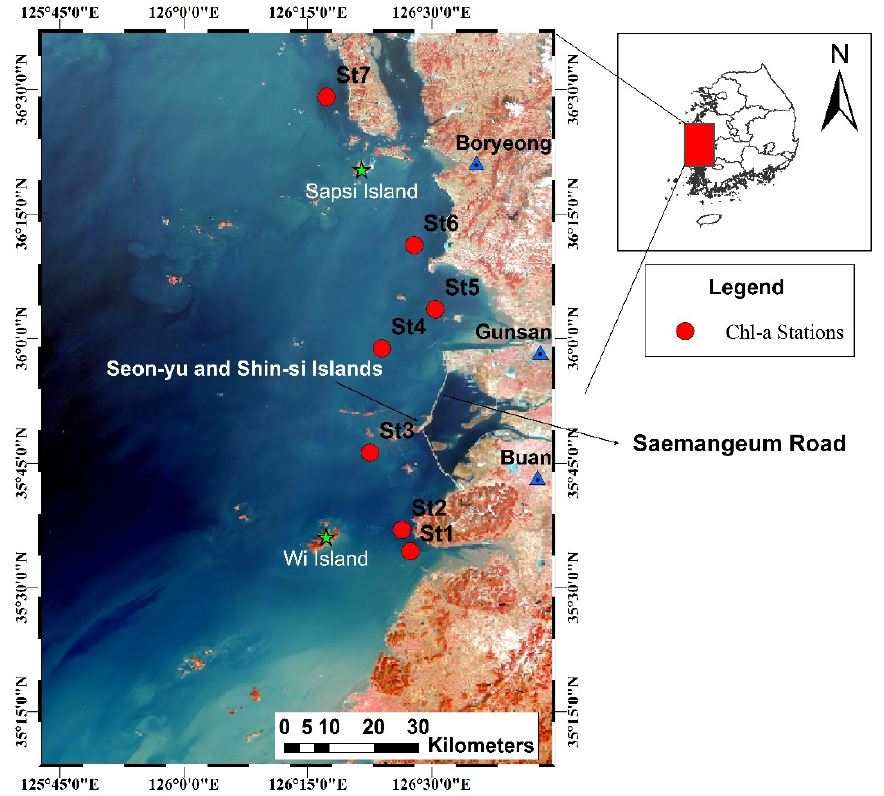
Figure 1. Location of the study region in the Korean West Sea and Chl-a sampling stations.